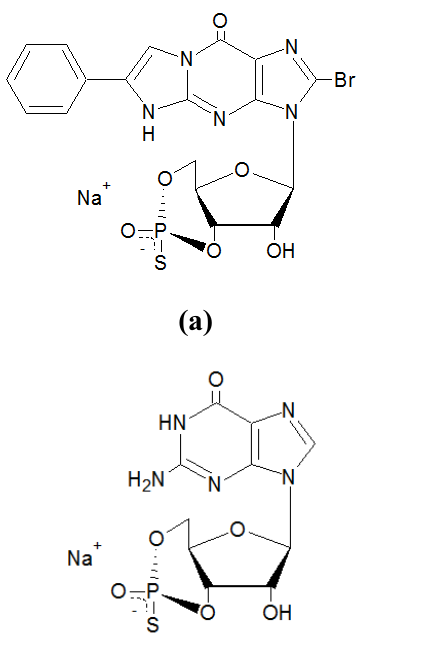
Figure 1. Chemical structures and names of cyclic nucleotide analogs. ( a ) (Rp)-8-Br-PET- cGMP-S, β -phenyl-1,N2-etheno-8-bromoguanosine-3',5'-cyclic monophosphorothioate (Rp- Isomer). ( b ) (Rp)-8-pCPT-cGMP-S, 8-(4-chlorophenylthio)guanosine-3',5'-cyclic monophosphorothioate (Rp- Isomer). ( c ) (Rp)-cGMP-S, Guanosine-3',5'-cyclic mono- phosphorothioate (Rp- Isomer). ( d ) (Rp)-8-Br-cGMP-S, 8-bromoguanosine-3',5'-cyclic monophosphorothioate (Rp- Isomer).